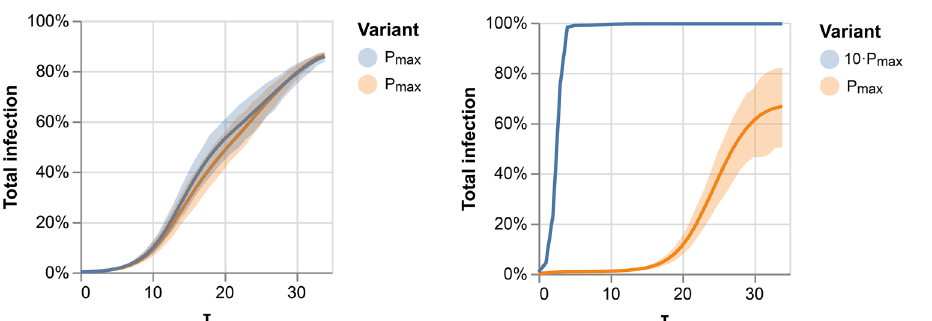
Figure 3. Determining competition conditions: The aggregated infection rate of each variant over a temporal random network. Left panel: two variants with the same infection probability. Right panel: the blue variant is ten times more